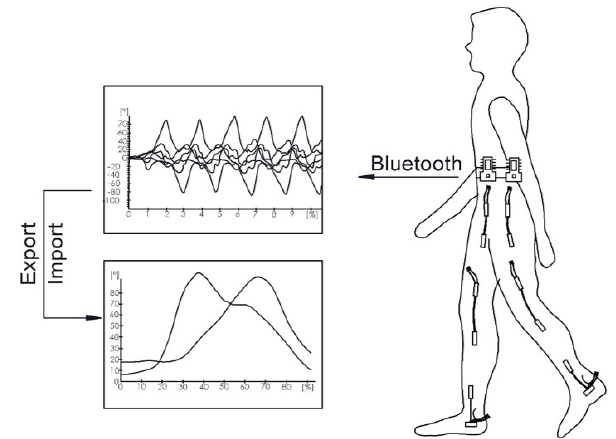
Figure 2. Block schema of the acquisition system.